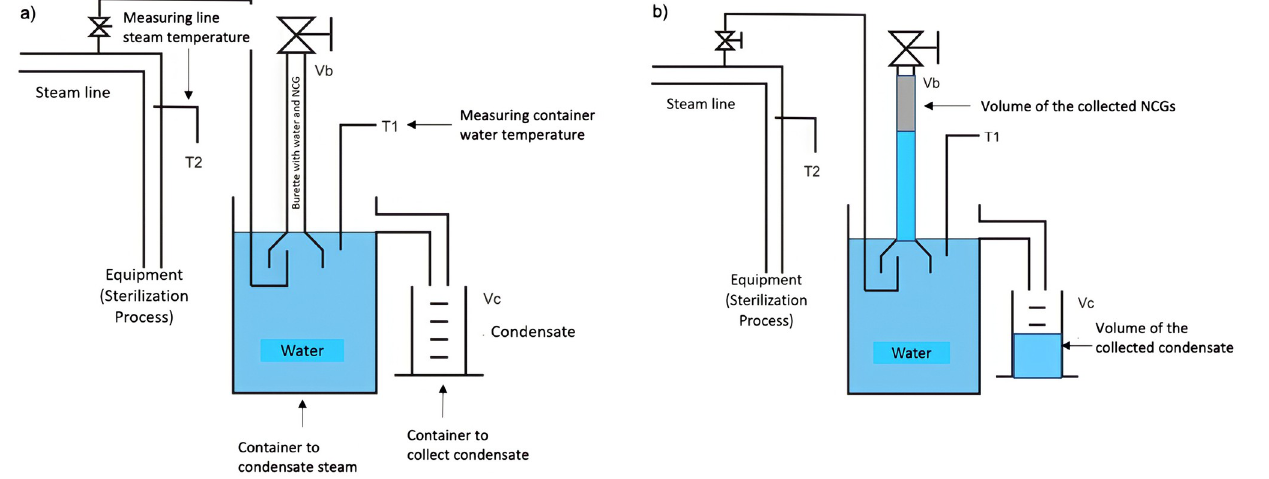
Fig 1. System representation for measuring non-condensable gases (NCG) used in the tests, adapted from EN285:2015, where: a) before the collection, b) after the measurement according to the norm.